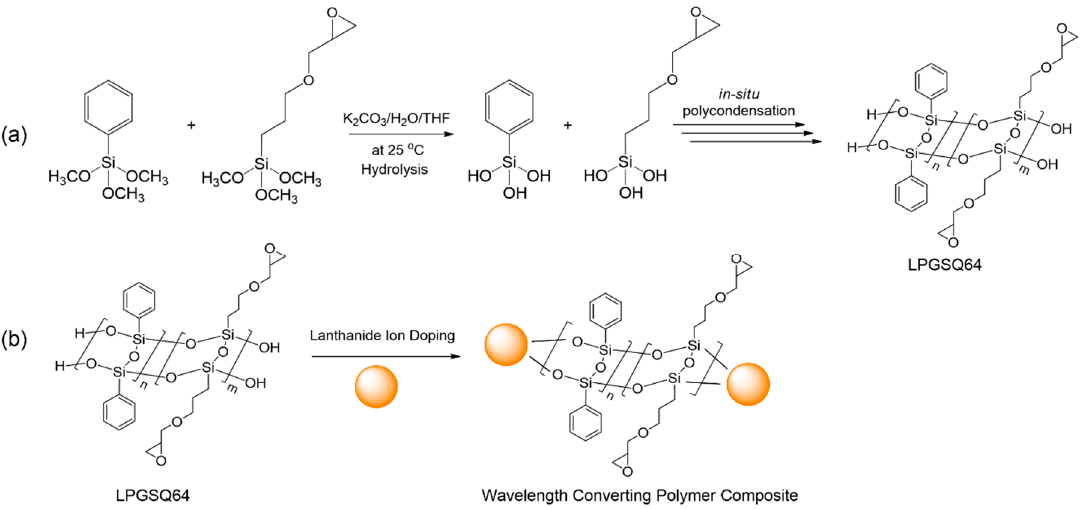
Scheme 1. ( a ) Synthesis of the hybrid polymer matrix ladder-structured poly(phenyl-co- glycidoxypropyl) silsesquioxane (LPGSQ64); ( b ) lanthanide ion Table 1. Assignments of 1 H and 29 Si NMR for the ladder-structured poly(phenyl-co- glycidoxypropyl) silsesquioxane (LSGSQ64).